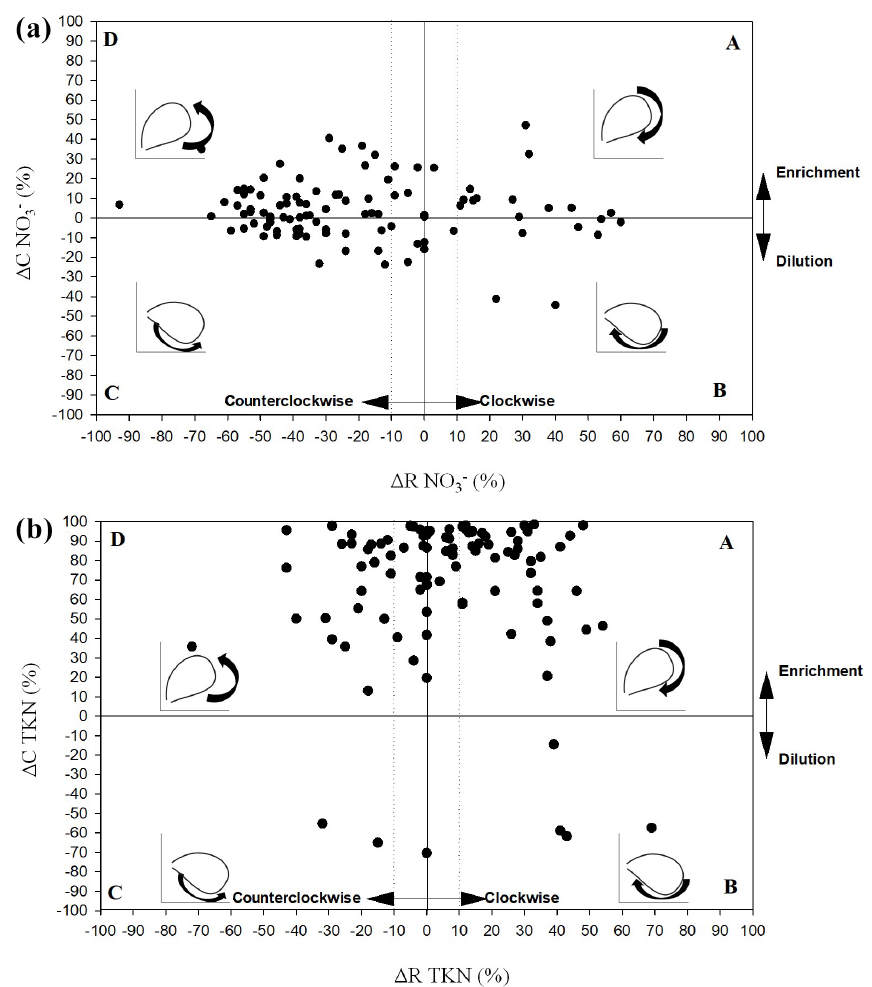
Figure 6. Representation of the C – Q hysteresis characteristics ( (cid:49)R and (cid:49)C ) of NO 3 − (a) and TKN (b) in the unity plane (A is the clockwise hysteresis with enrichment, B is the clockwise hysteresis with dilution, C is the counterclockwise hysteresis with dilution, and D is the counterclockwise hysteresis with enrichment). The vertical and horizontal dotted lines delimit the hysteresis loops with a small area. Circular arrows show the direction of clockwise and counterclockwise hysteresis (authors’ own creation; based on Butturini et al., 2006).